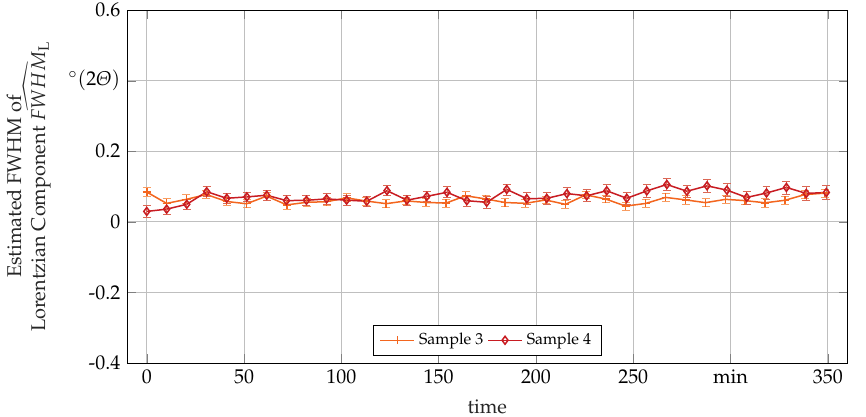
Figure A3. Estimated FWHM of the Gaussian component function fitted to the ( 111 ) - γ -peak over the time spent in the HT measured with in-situ XRD. Values for samples 1 and 2 could not be given due to peak overlap with ( 002 ) - (cid:101) -peak.